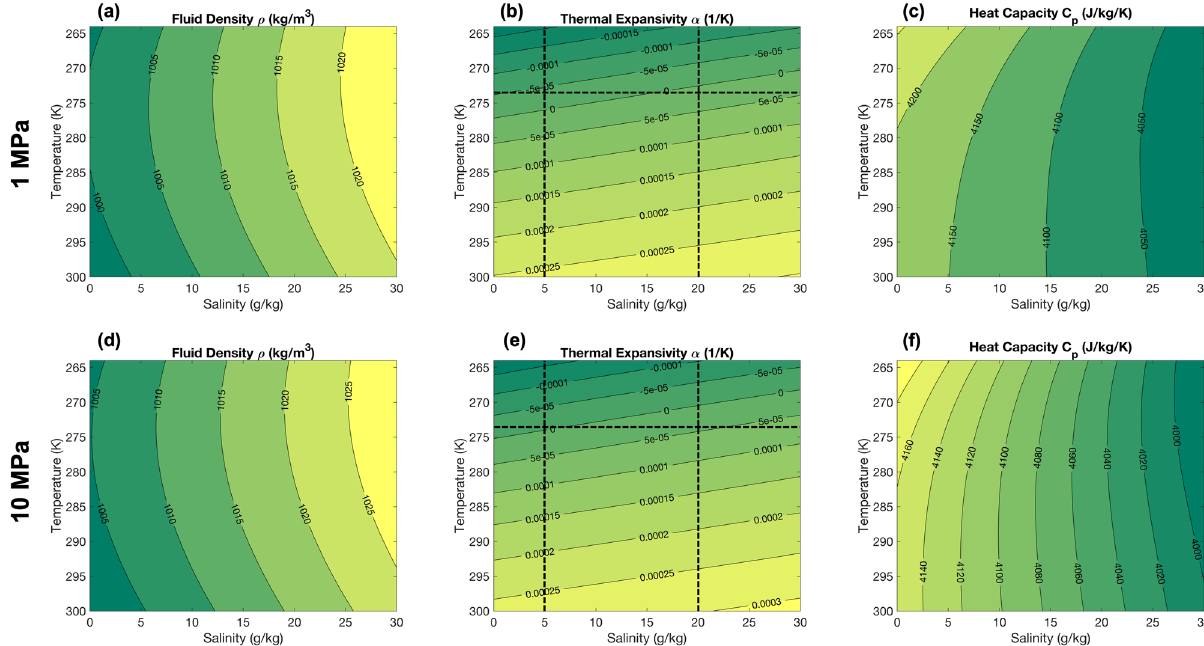
Fig. 2 Contours of density, thermal expansivity, and heat capacity vs. ocean salinity and temperatures. Shown at pressures of 1 MPa ( a – c ) and 10 MPa ( d – f ). Black dashed lines indicate the lower and upper limits on ocean salinity based on in-situ observations made by Cassini 6,42 . For the ocean temperature, we assume 274 K 44